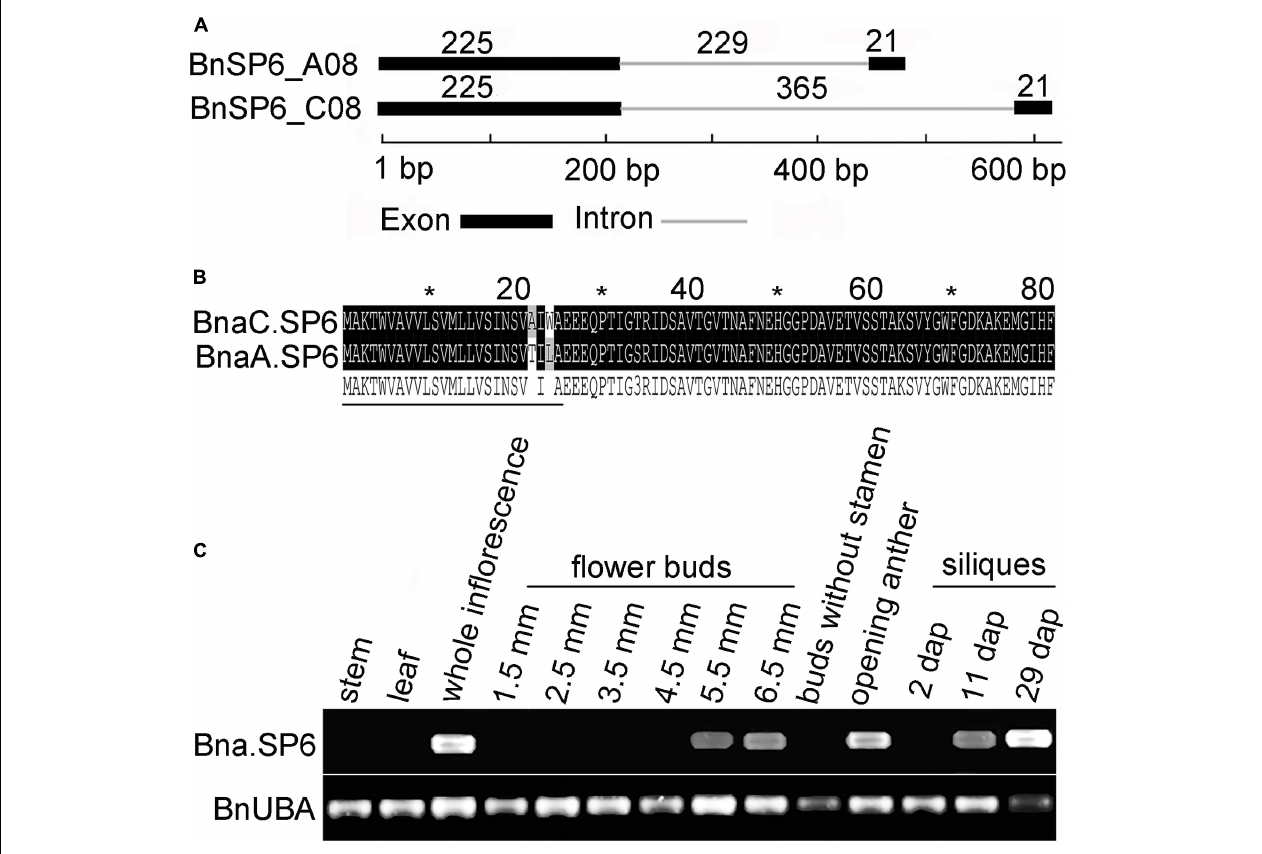
FIGURE 1 | Structural analysis of the small peptide gene Bna.SP6 in Brassica napus . (A) Schematic of BnSP6_C08 and BnSP6_A08 gene structures. Exons and intron are indicated by black boxes and gray line, respectively. (B) Alignment of the deduced amino acid sequences of BnaC.SP6 and BnaA.SP6 . The signal peptides are indicated by thin black lines under the corresponding residues. (C) Detection of Bna.SP6 transcript in B. napus by RT-PCR. Buds were 1.5, 2.5, 3.5, 4.5, 5.5, and 6.5 mm length; 2, 11, and 29 dpi, siliques 2, 11, and 29 days after artificial pollination.